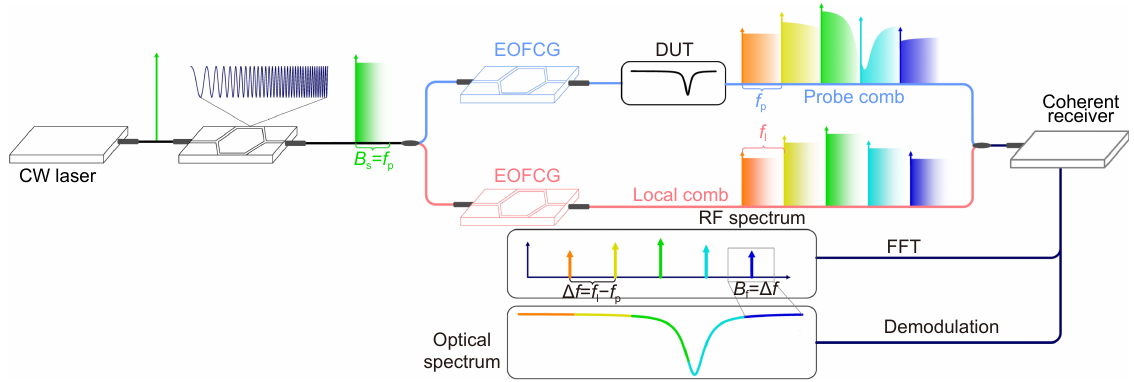
Fig. 1 | The schematic to show the operation principle of proposed EO-DCS with real-time interleaved spectrum. CW laser: continuous- wave laser; EOFCG: electro-optic frequency comb generation; DUT: device under test; RF: radio frequency; FFT: fast Fourier